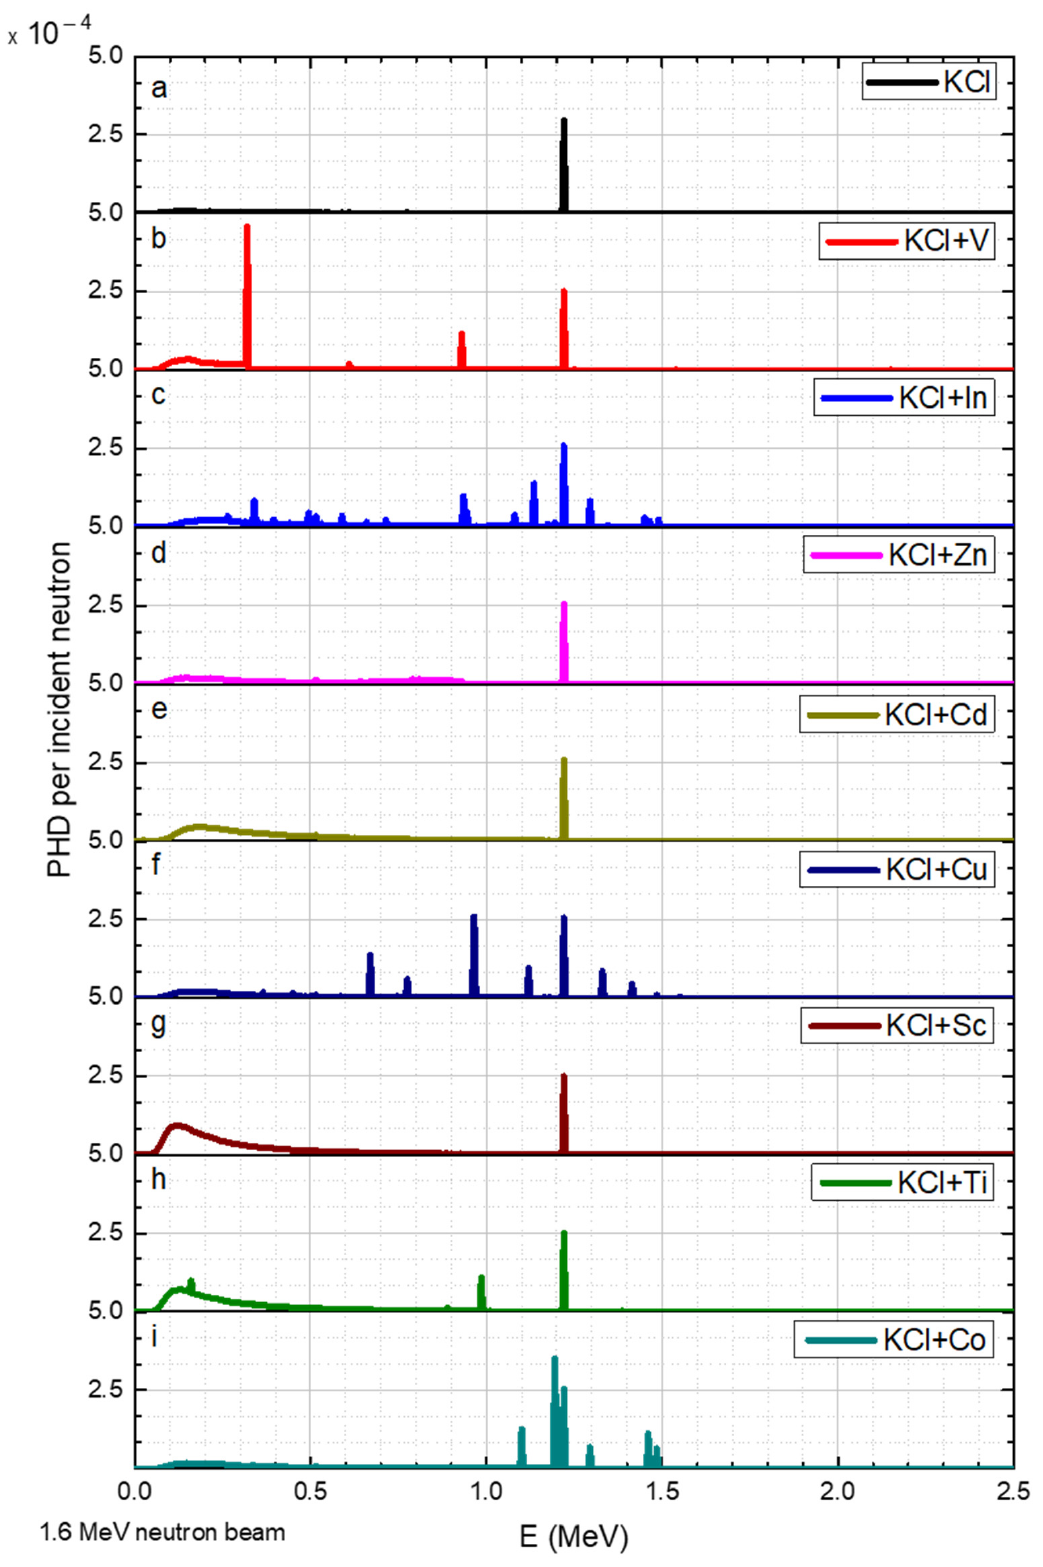
Figure 7. Irradiation of KCL salt and its elements with 1.6 MeV neutron, where the y axis is the gamma pulse height distribution (PHD) per incident neutron obtained in the detector and the x axis is the gamma radiation energy. The data corresponds to a range of elements ( a – i ) added to the KCl.